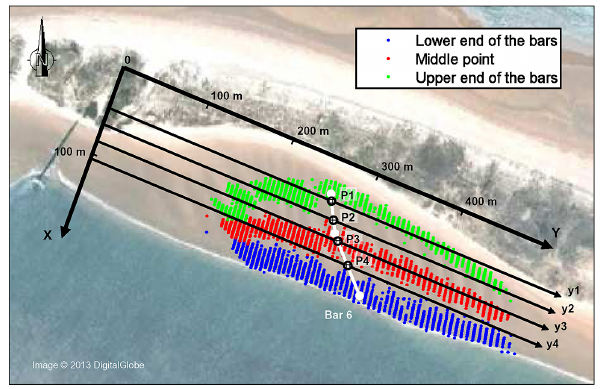
Figure 4. Coordinate system and bar digitisation. The x and y axes stand for the cross-shore and the alongshore direction respectively. The colour points represent the digitised data (each bar is repre- sented by three points); blue, red and green are the lowest, the mid- dle and the upper points of the bars respectively. The bar positions (P1–P4) are defined along the y 1– y 4 axes, at x 1 = 45, x 2 = 65, x 3 = 85, and x 4 = 105m respectively (see positions of bar 6, in white). Image from Google Earth, © 2013